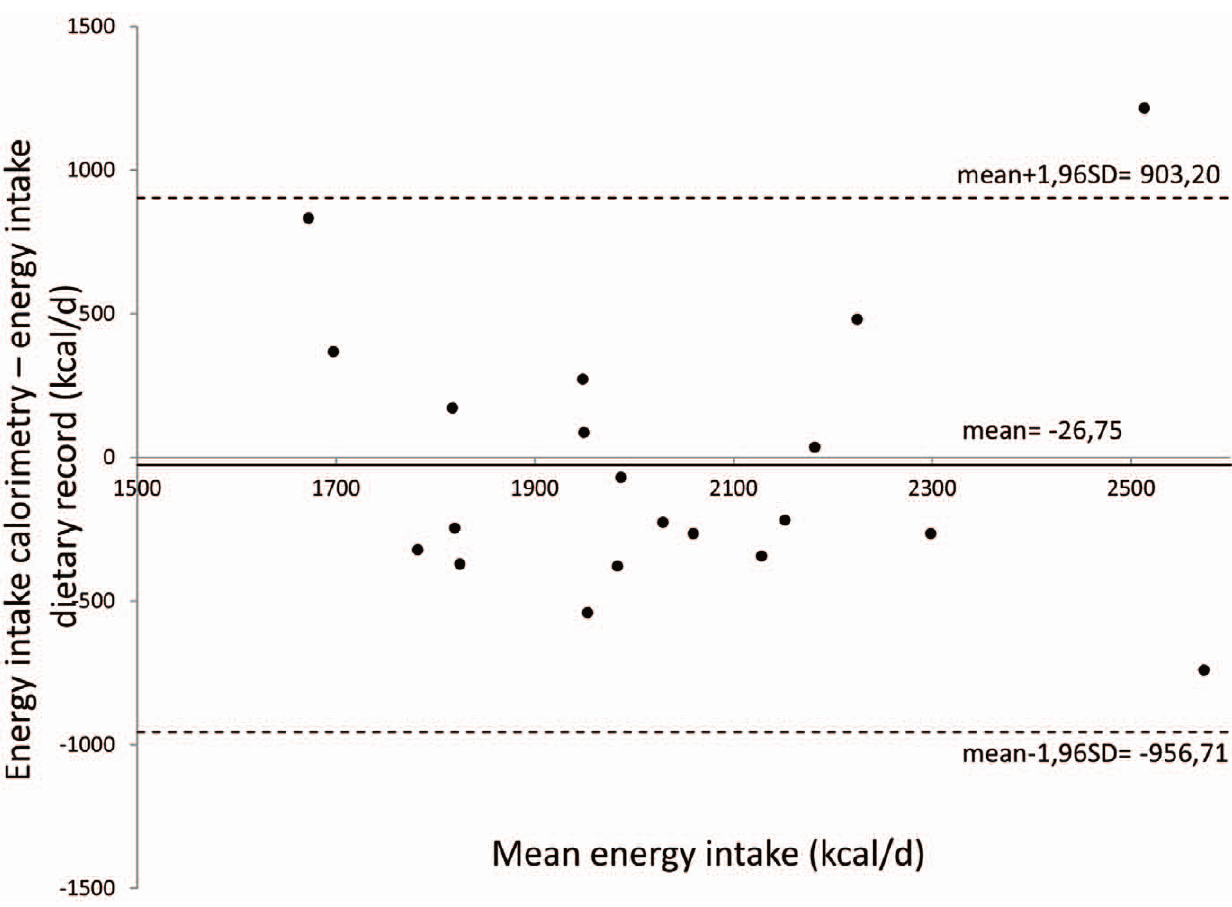
Figure 2. Bland-Altman plot comparing energy intake measured using indirect calorimetry (kcal/d) and energy intake calculated from the dietary records (kcal/d). Mean energy intake measured by calorimetry and dietary record are plotted against the difference between energy intake measured by calorimetry and by dietary record.